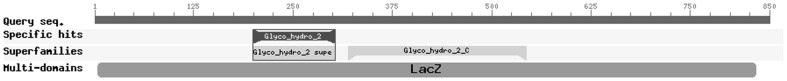
The putative domain of the protein belonged to GHs family 2 (Glyco_hydro_2).